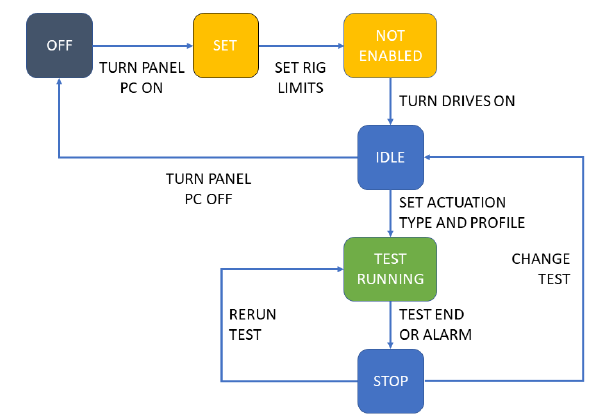
Fig. 11. States and transitions for the IMAGINE test rig software. Once the control panel has been turned on, the limits of the test rig must be set. They include: the maximum force, maximum speed, maximum motor temperature and the stroke minimum and maximum values. After all the limits have been set, the power converters can be turned on and the settings of the actuation systems selected. These settings include the actuation type and profile.